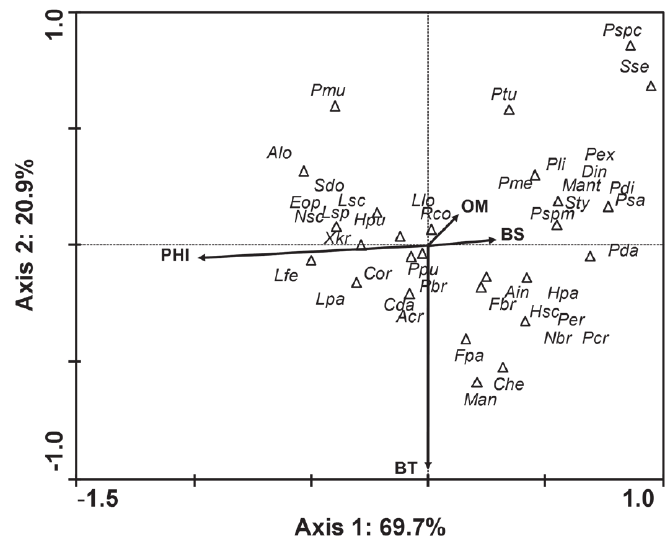
Fig. 2 - Results of canonical correspondence analysis, showing the correlation between abundance of decapod crustaceans and environmental factors sampled during the study period (January 1998 through December 1999) in the Ubatuba region. BT: bottom temperature, BS: bottom salinity, OM: organic matter, Acr : A. cribrarius , Ain : A. intrinsecus , Alo : A. longinaris , Cda : C. danae